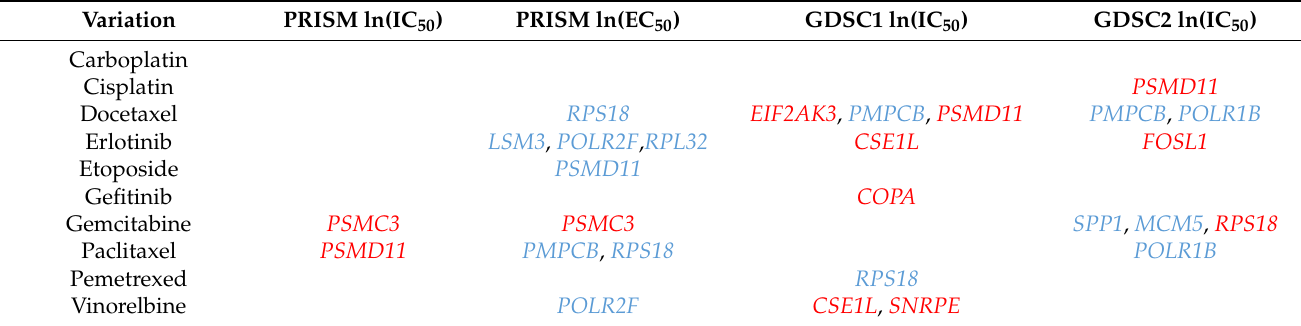
Drug activity measurements were natural log transformed. Red font indicates the gene has a higher expression in the resistant cell lines than in the sensitive cell lines. Blue font indicates the gene had a lower expression in the resistant cell lines than in the sensitive cell